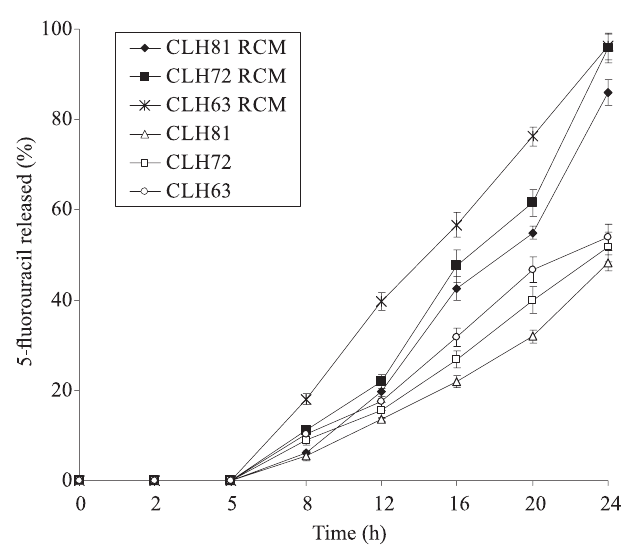
FIGURE 3 - In vitro release profile of 5-fluorouracil from formulation coated with 500 mg without and with rat caecal medium